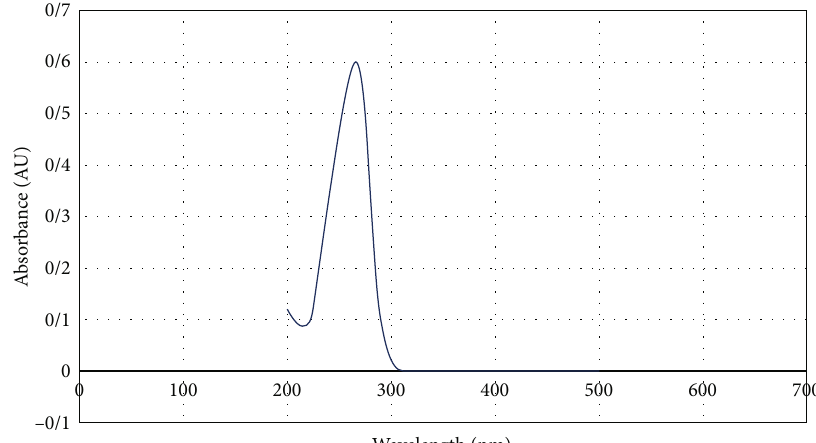
Figure 1: UV-vis spectrum of Se